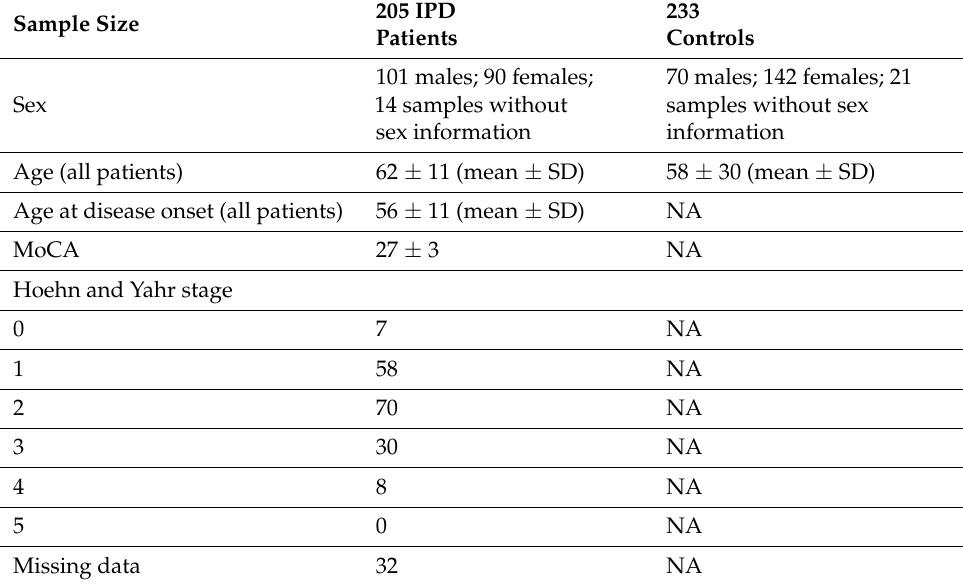
Table 1. Clinical characterization of the IPD patients. MoCA; NA = Not Applicable. The clinical characteristics listed in Table 1 correspond to the entire dataset downloaded (GEO: GSE99039). For the subsequent analysis, only 204 PD patients and 227 controls were retained (see Materials and Methods, Section 2.4 for further